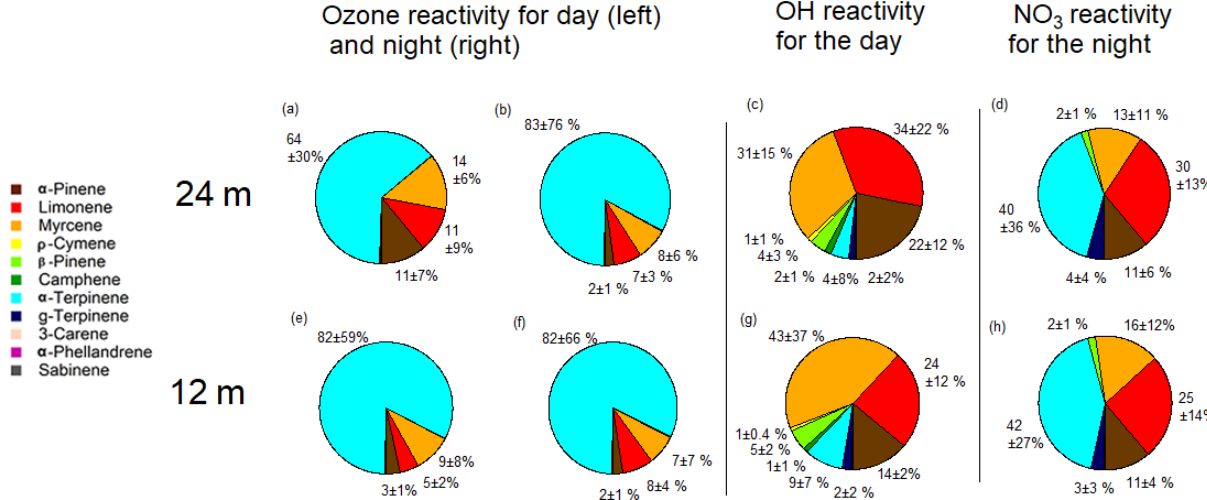
Figure 4. Pie charts representing day-time (a, e) and night-time (b, f) ozone reactivity, OH reactivity (only for day, c and g ) and NO 3 reactivities from 17 to 20 October 2015, with the average percentages and standard deviations (only for night, d and h ), for 12m on the bottom and 24m on the top. The day period was from 09:00 to 17:00 and the night period was from 20:00 to